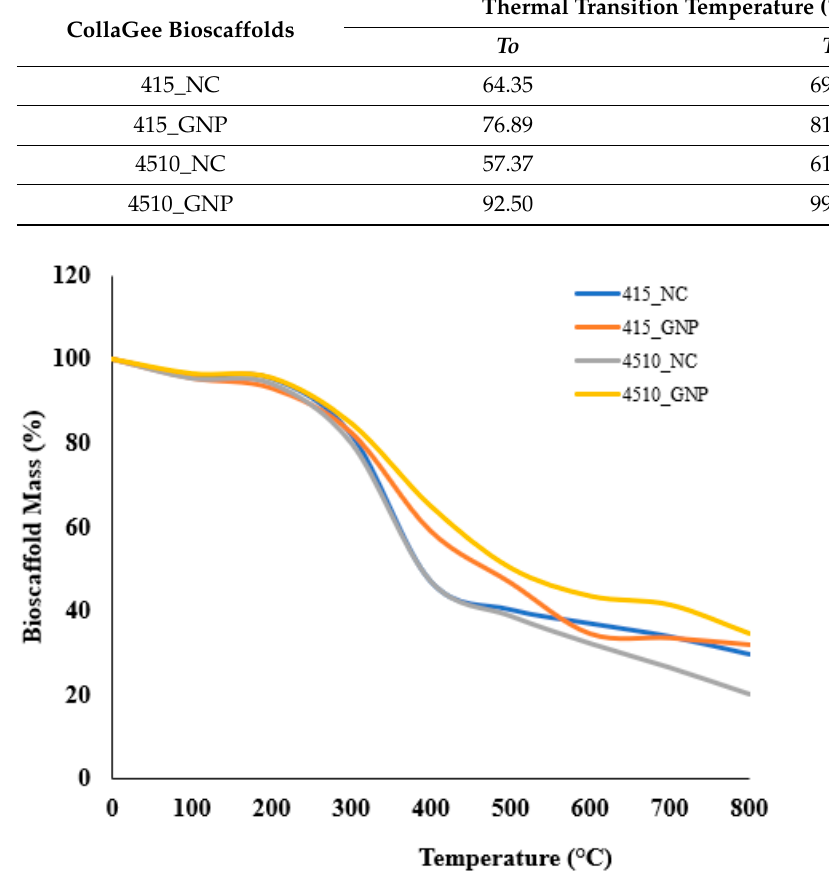
Table 1. Thermal transition temperatures of different groups of CollaGee biomaterials. To , onset temperature; Tp , the temperature of the scaffold peak.